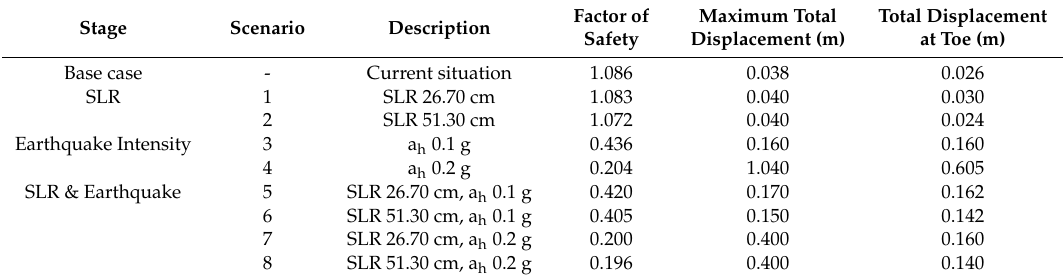
Table 1. Maximum total displacement for di ff erent scenarios.